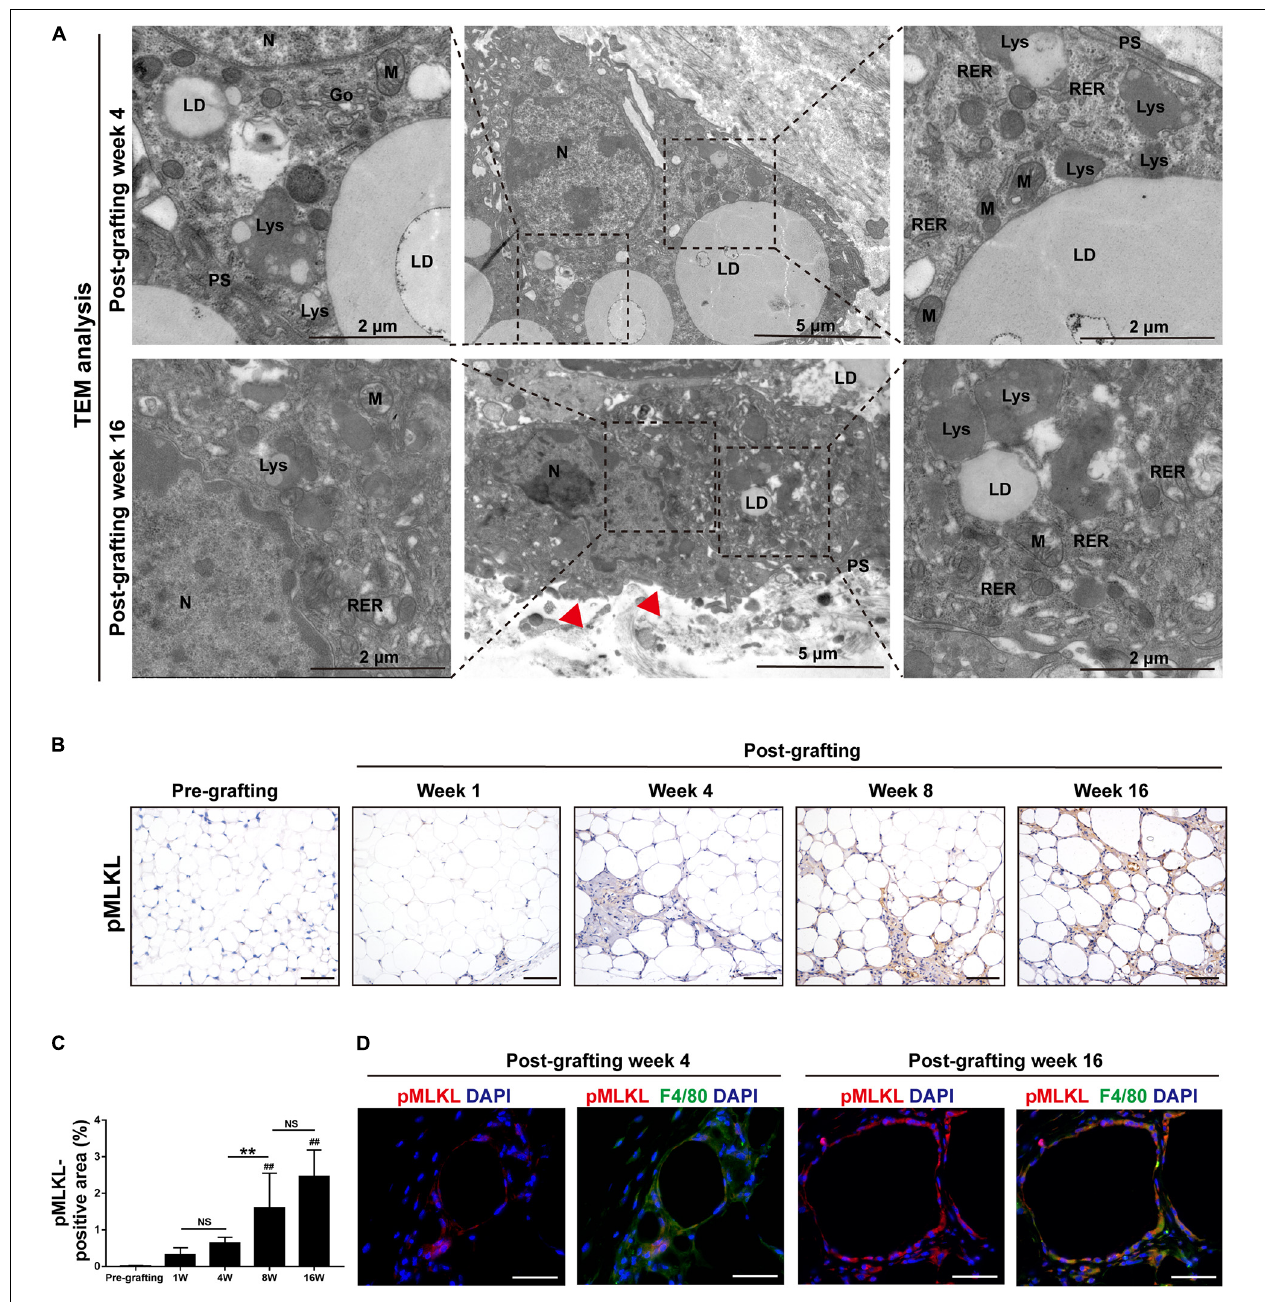
FIGURE 3 | Necroptosis is activated in MFCs in fat graft tissue. (A) TEM of the ultrastructure of MFCs located in fat tissue after grafting. N, nucleus; LD, lipid droplet; PS, pseudopodia; M, mitochondria; RER, rough endoplasmic reticulum; and Lys, lysosome. Red arrowheads indicated the damaged plasma membrane. (B,C) Representative pMLKL staining (B) and quantification of the pMLKL-positive area (C) in fat tissue before and after grafting. (D) Representative immunofluorescence staining of pMLKL (red) and F4/80 (green) in fat tissue after grafting. Scale bars = 50 µ m. Data are presented as the mean ± SD. ## P < 0.01 compared with the pre-grafting group; ** P <